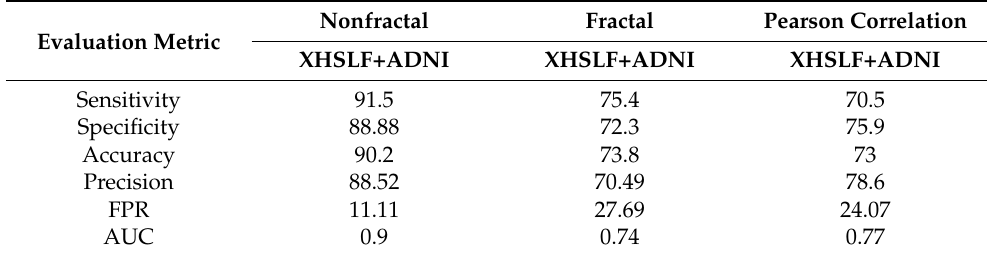
Table 7. Sensitivity, specificity, accuracy, precision, FPR (in %) and AUC of classification of AD vs. NC based on functional connectivity of rs-fMRI for XHSLF+ADNI